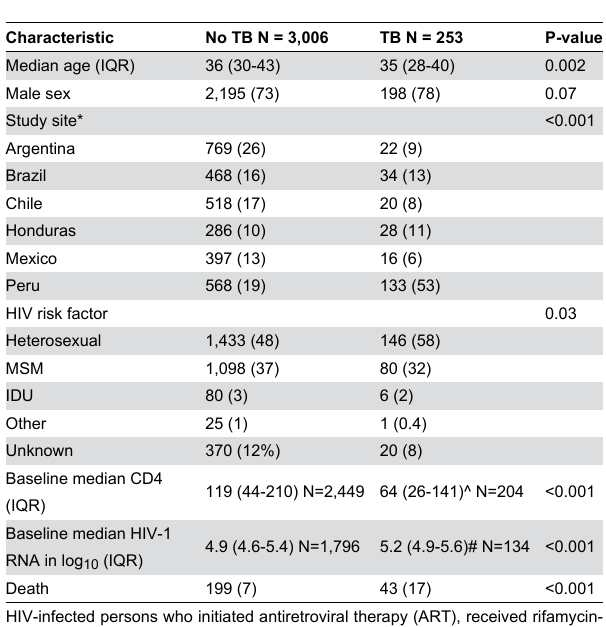
Table 1. Characteristics of the Study